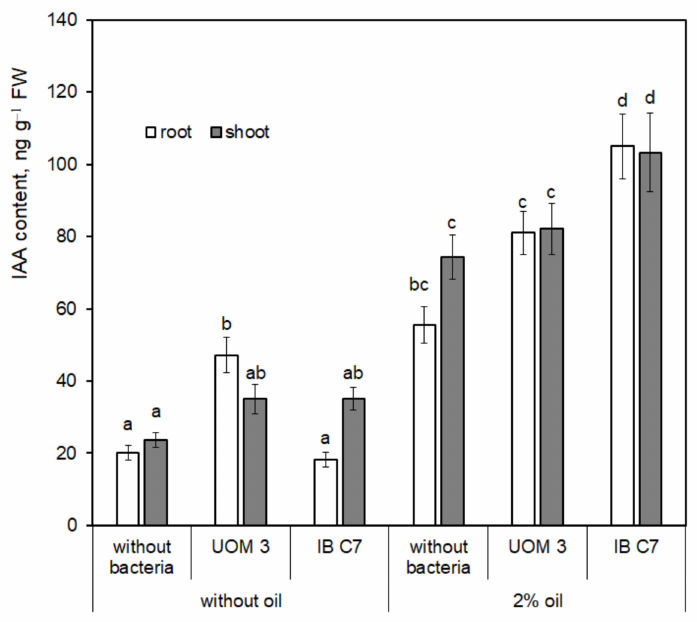
Figure 5. Indole-3-acetic acid content in shoots and roots of barley plants (ng g − 1 fresh weight). UOM 3 and IB C7—treatments with introduction of Enterobacter sp. UOM 3 and P. hunanensis IB C7, respectively. Statistically different means (n = 9) are marked with different letters ( p ≤ 0.05).